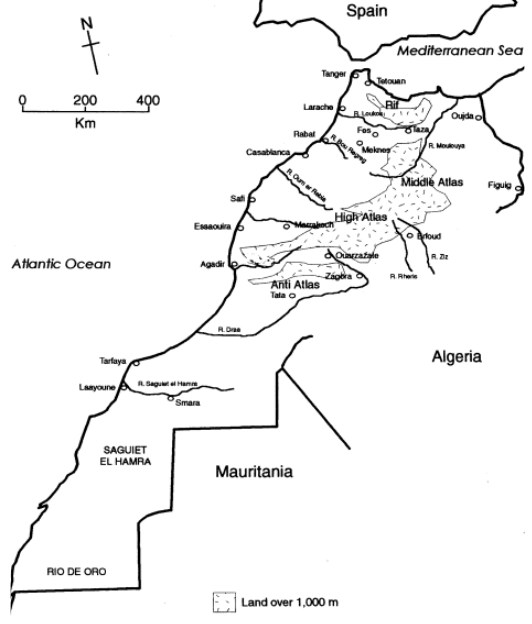
Figure 1. Map of